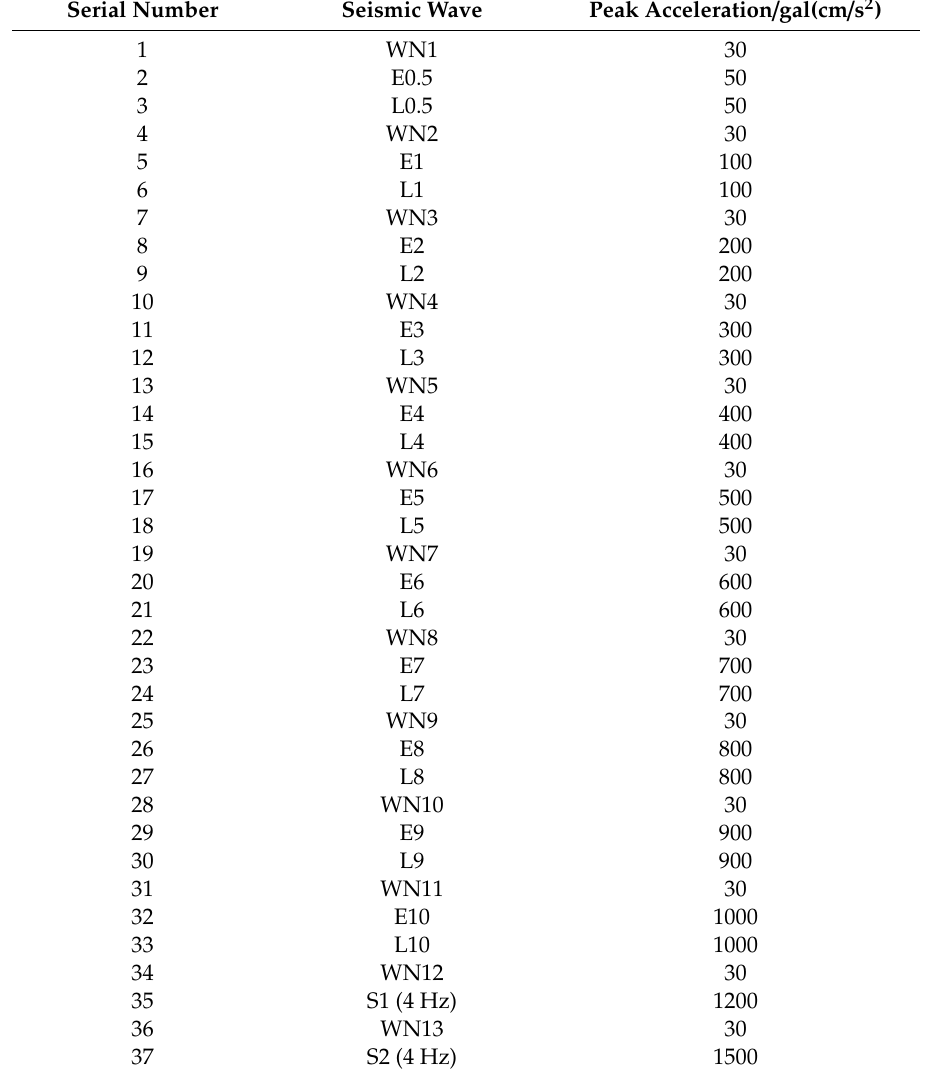
Table 2. Loading scheme of the shaking table